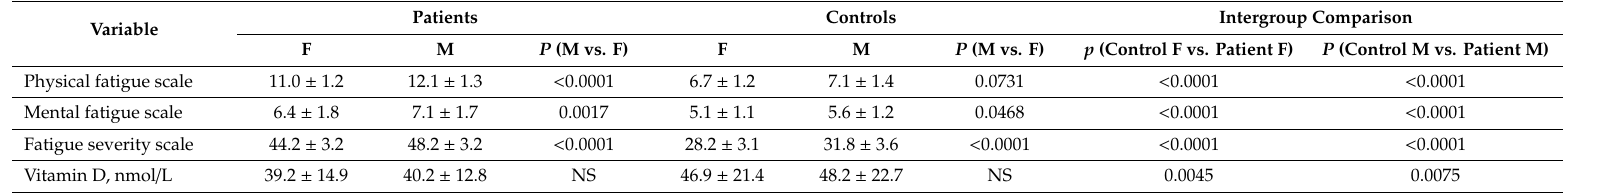
Table 4. Gender di ff erences of fatigue scale scores and vitamin D levels between patients and